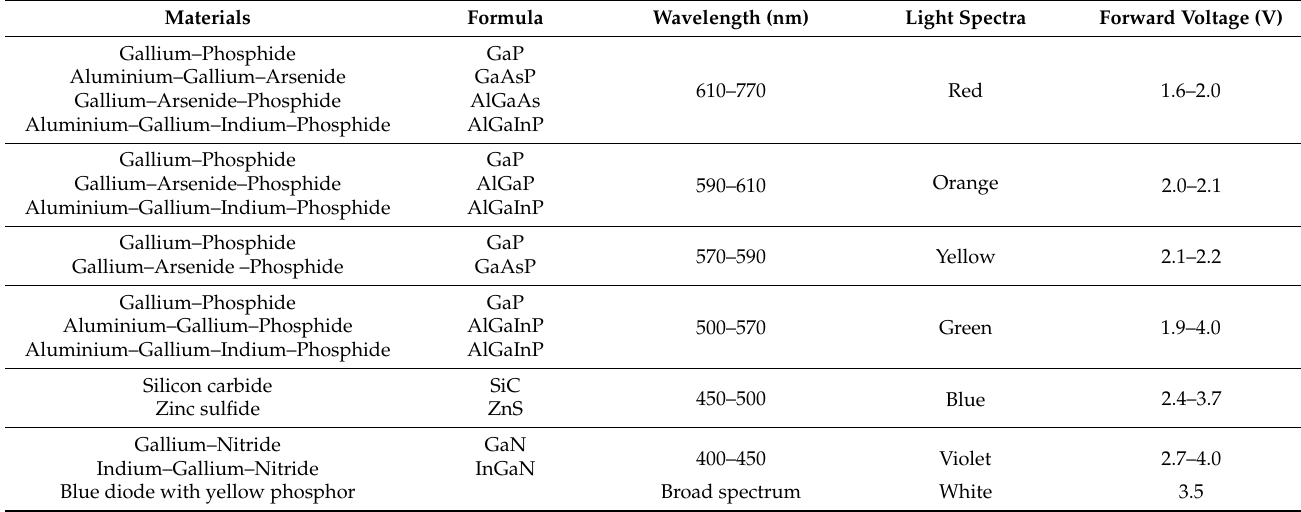
Table 3. Semiconductors in LEDs and their emission spectra